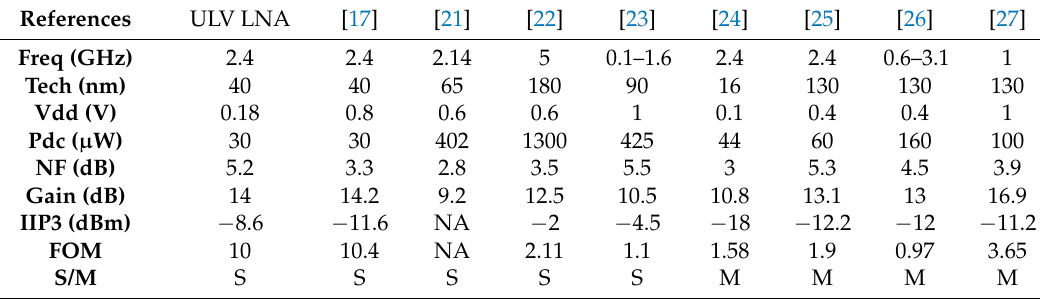
Table 1. Performance summary and comparison with state-of-the-art